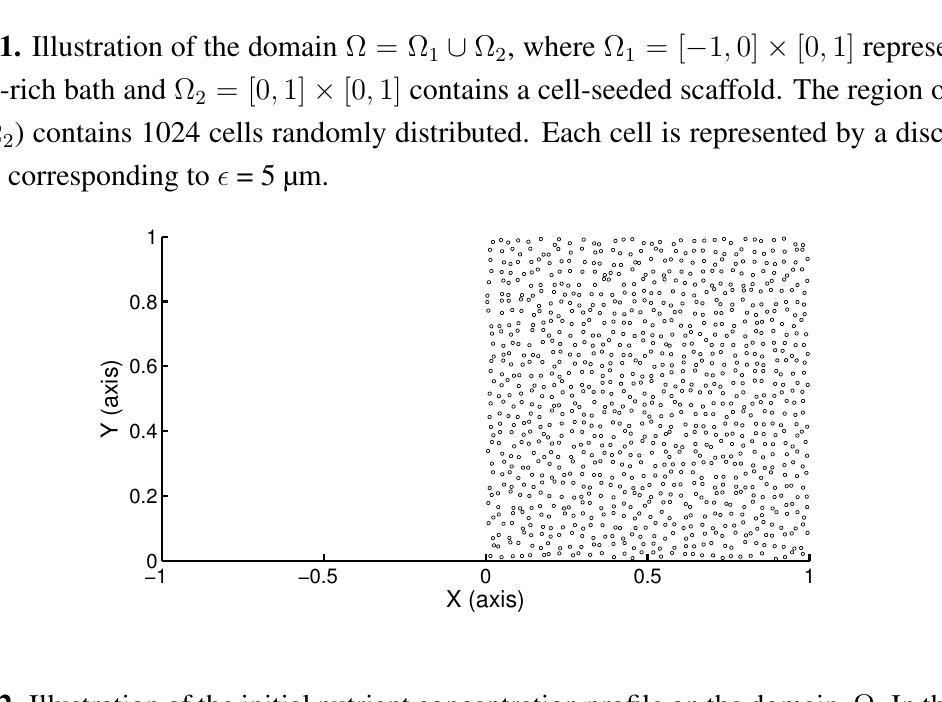
Figure 2. Illustration of the initial nutrient concentration profile on the domain, Ω . In the left half, Ω , the normalized nutrient concentration is assumed to be u = 0 . 2 , and on the right 1 half, Ω , the initial nutrient concentration is taken to be 2